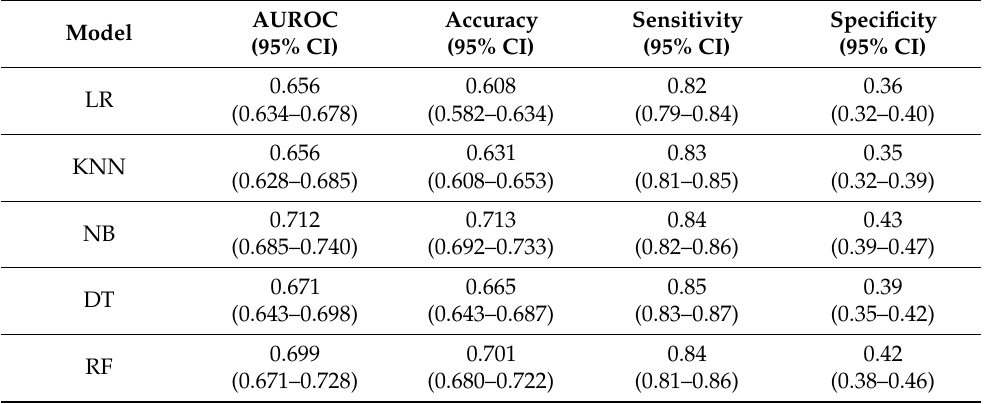
Table 2. Performance of all machine learning models.